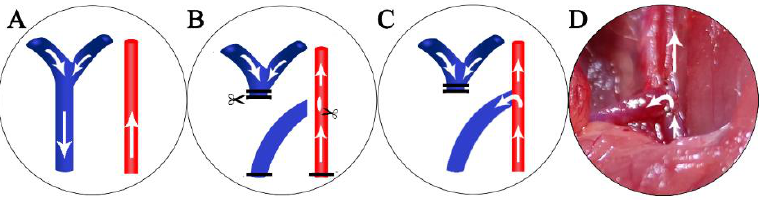
Figure 1. Surgical procedure: ( A ) dissection of the common carotid artery (red) and external jugular vein (blue); ( B ) after the placement of vascular clamps and ligation of the vein, an incision was made on the wall of the artery, followed by the transection of the vein; ( C ) end-to-side anastomosis was performed with running suture; ( D ) photograph of a completed AVF. The arrows indicate the direction of blood flow. AVF: autologous arteriovenous fistula.